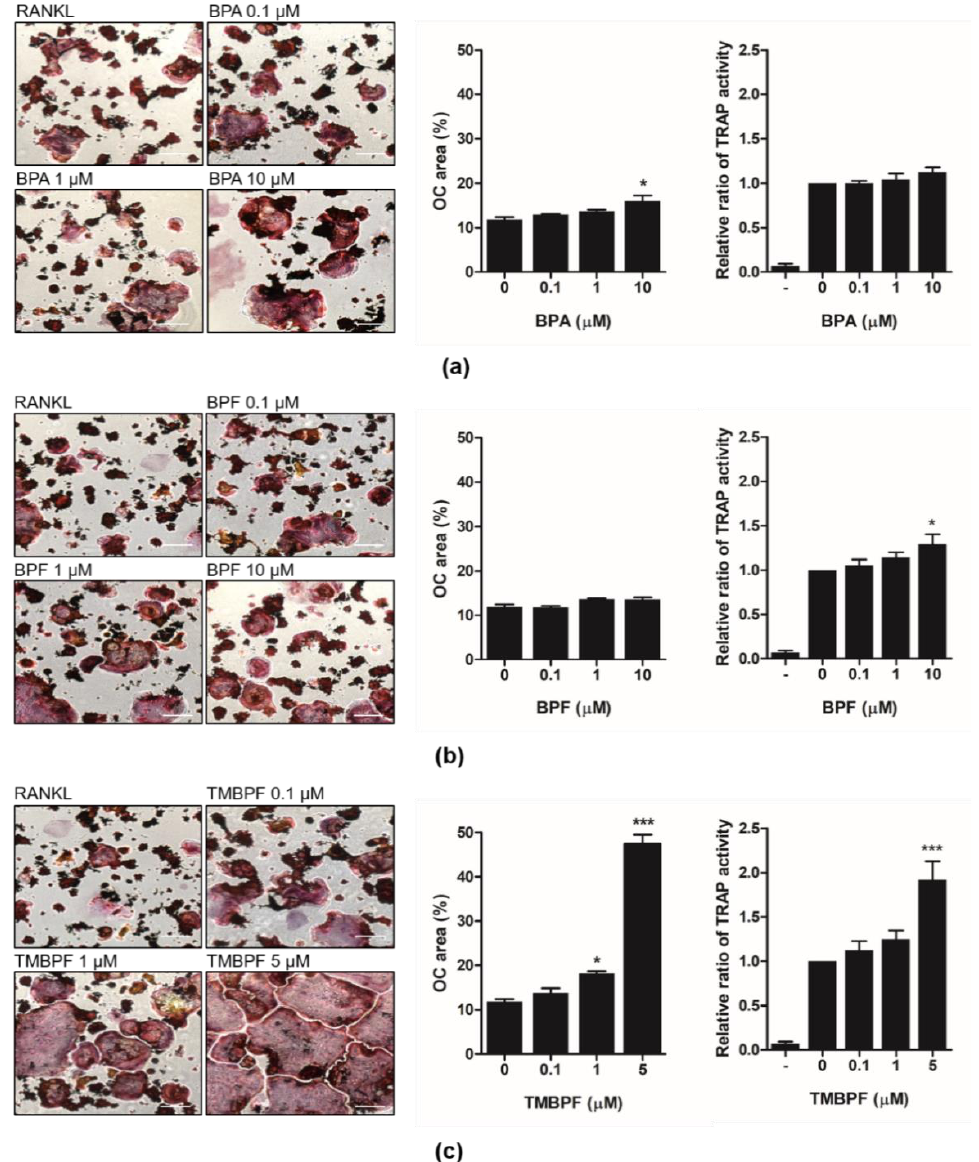
Figure 3. Effect of BPA, BPF, and TMBPF on osteoclast differentiation in mouse osteoclast precursor RAW 264.7 cells. RAW 264.7 cells were cultured with a complete medium containing RANKL (50 ng/mL) in the presence of different con- centrations of ( a ) BPA, ( b ) BPF, and ( c ) TMBPF for 3 days. Cells were stained using a tartrate-resistant acid phosphatase (TRAP) staining kit. The area (%) of TRAP-positive multinucleated osteoclasts was quantified. The relative ratio of TRAP activity was measured at 405 nm. The (-) group refers to no RANKL treatment. All experiments were performed in tripli- cates. * p < 0.5, *** p < 0.001 vs. control. Scale bar: 200 µm.